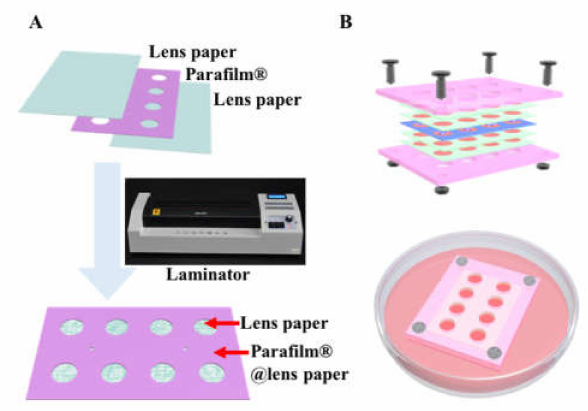
Figure 1. Fabrication of cell-in-gel-in-paper (CiGiP) cell invasion platform. ( A ) Preparing of paper